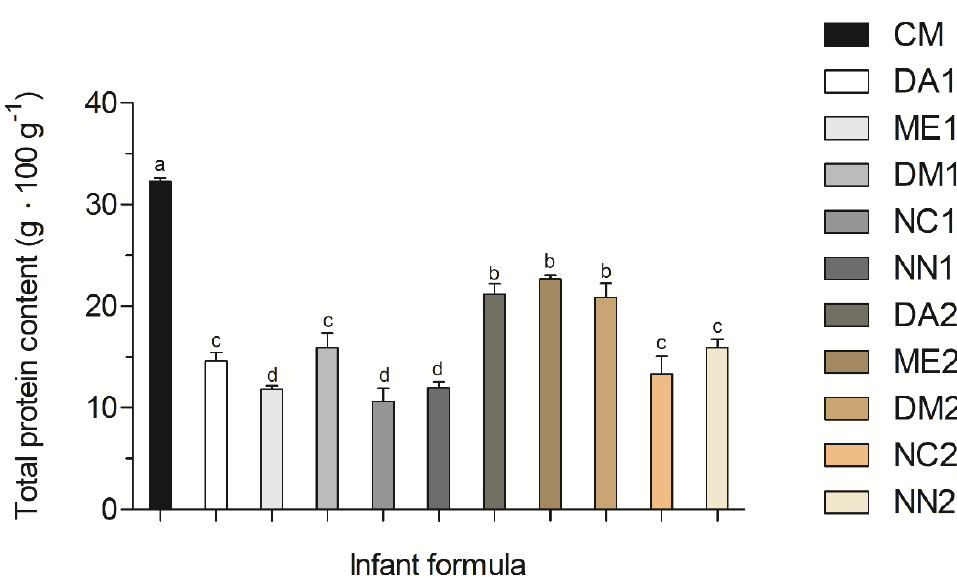
Figure 1. Protein content (g · 100 g − 1 ) of cow milk (CM) and phase 1 and phase 2 infant formulas. Formulas from the same brand were coded with the same two capital letters and numbers 1 or 2 to indicate the phase of infant growth. Three samples of each batch were analyzed and the values are expressed as means ± SD ( n = 3). Different lowercase letters over the bars indicate differences between brands at a significance level of p < 0.05.